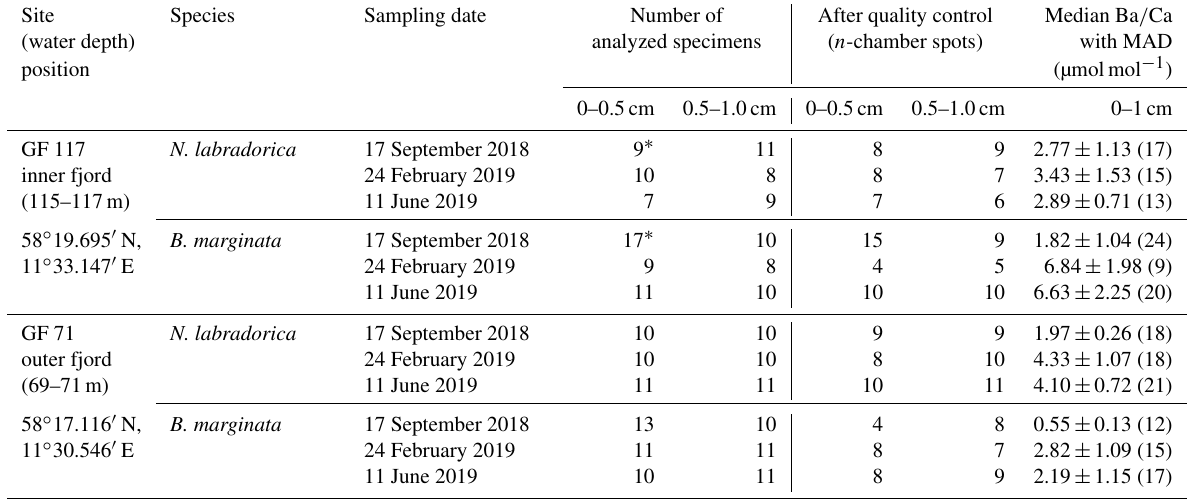
Table 1. Sampling sites and number of analyzed specimens per species and sediment interval for each site and sampling occasion, before and after quality control of measurements. Median Ba / Ca with median average deviation (MAD) of n -chambers in µmolmol − 1 per species, site, and season (number of data points, i.e., analyzed specimens, indicated in brackets) for top 1cm sediment. Site Species Sampling date Number of After quality control Median Ba / Ca analyzed specimens ( n -chamber spots) with